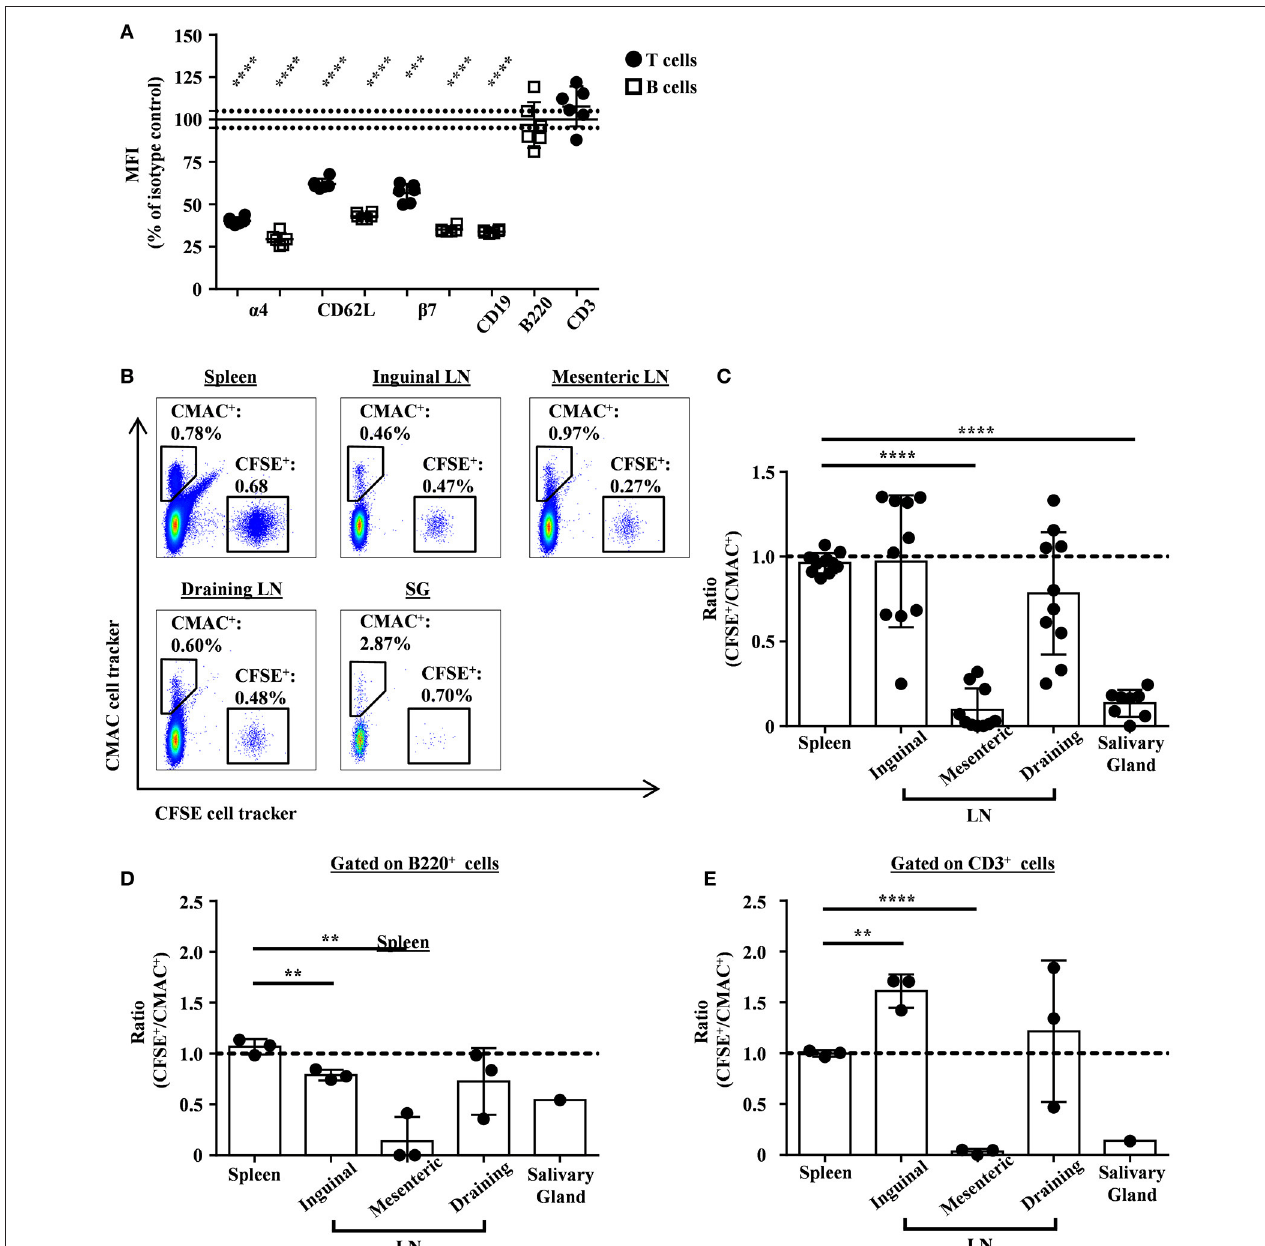
FIGURE 5 | Monoclonal antibody Ly9.7.144 impairs the ability of lymphocytes to migrate into the inflamed salivary glands and mesenteric lymph nodes of SjS mice. Percentages of relative MFI from the spleen of Ly9.7.144-treated mice for 16 h over the mean MFI from isotype-treated mice are shown for the different surface proteins (A) . Black dots indicate that MFI values were from pre-gated T cells and empty squares indicate that MFI values were from pre-gated B cells. Results are expressed as mean ± SD. *** p < 0.001; **** p < 0.0001 (unpaired two-tailed t -test). Data is from one independent experiment. Representative dot plots for migrating splenocytes into spleen, lymph nodes and salivary gland from age-matched NOD.H-2 h4 recipient mice are shown (B) . Transferred splenocytes from Ly9.7.144-treated NOD.H-2 h4 mice were stained with CFSE cell tracker. Transferred splenocytes from istoype-treated NOD.H-2 h4 mice were stained with CMAC cell tracker. Same cell numbers from each mouse were mixed and i.v. administrated. After 24h the CFSE + /CMAC + ratio was calculated for each organ. The ratios of total transferred splenocytes are shown (C) as also the ratio of transferred B220 + (D) and CD3 + (E) cell subsets. A dashed line indicates ratio value one. Results are expressed as mean ± SD. ** p < 0.01; **** p < 0.0001 (unpaired two-tailed t -test). Data is pooled from three independent experiments (C) . Data is from one independent experiment (D,E) . To be able to see the B220 + and CD3 + transferred cell subsets migrating into the salivary gland, the three salivary glands from the recipient mice were pooled in one unique sample acquisition (D,E)